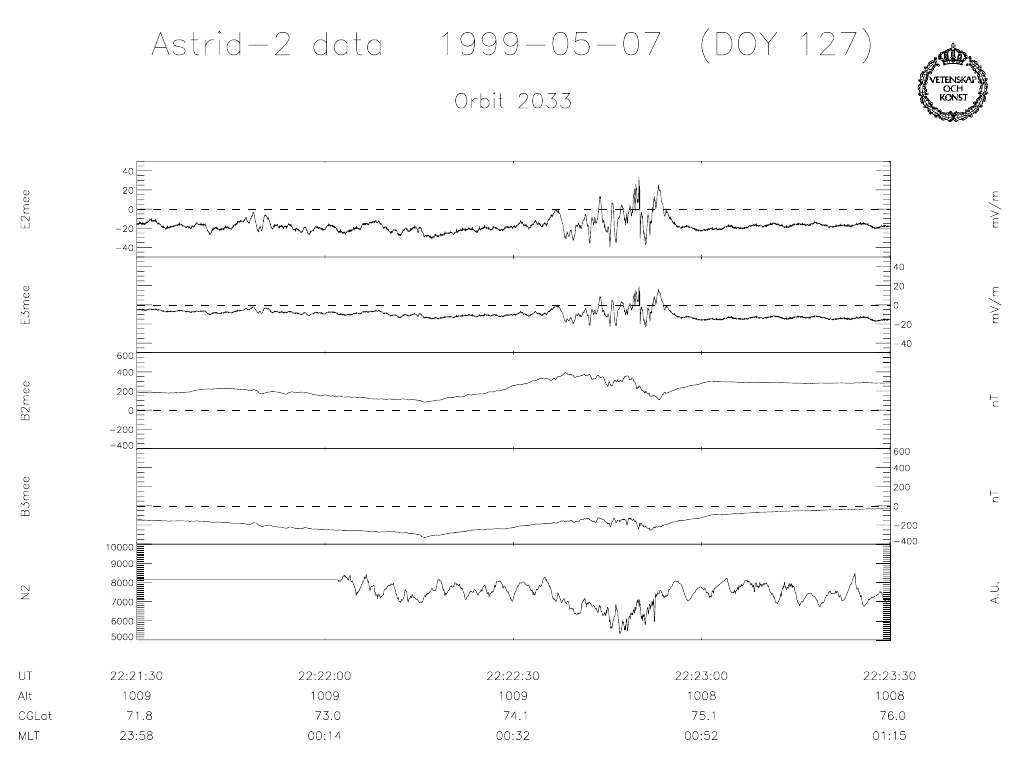
Fig. 6. Close up view of the electric field, magnetic field and plasma density data between 22:21:30 UT and 22:23:30 UT when Astrid-2 crossed the narrow precipitation region near the poleward auroral oval